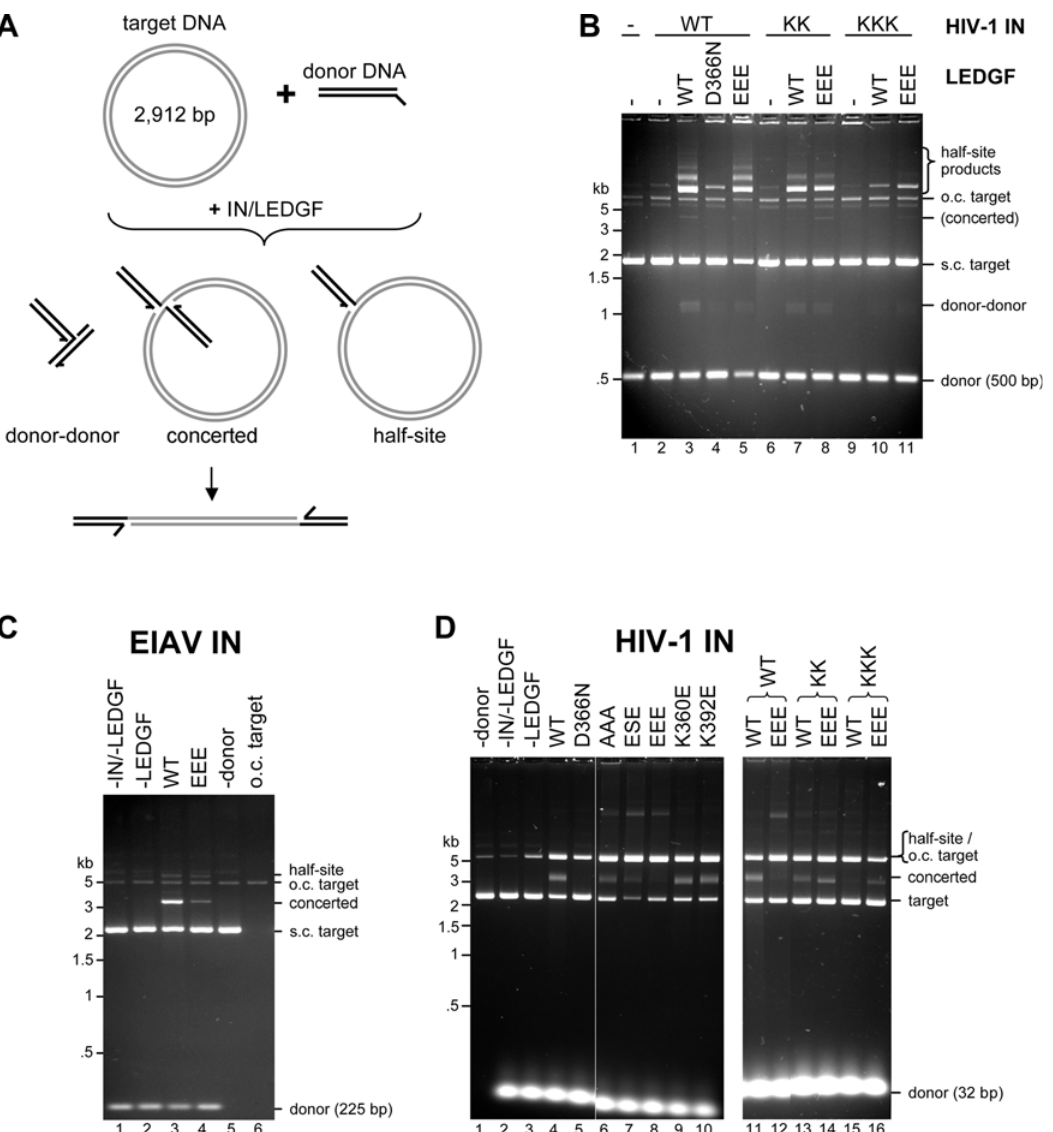
Figure 4. Effects of Mutations within the NTD–IBD Interface on LEDGF–Dependent Strand Transfer Activities of Lentiviral INs. (A) Schematic of the reactions mediated by IN in the presence of circular DNA target: concerted integration results in a linear product while half-site reactions produce branched molecules (circular half-site and donor-donor). (B) HIV-1 IN activity under established conditions that favor half-site integration [22]. WT, KK, or KKK HIV-1 IN was incubated with 10 nM 500-bp donor DNA and supercoiled target DNA in the absence (lane 2) or presence (lanes 3–11) of WT, D366N, or EEE LEDGF. The products separated in an agarose gel were detected with ethidium bromide. Lane 1 contained a mock sample, with both IN and LEDGF omitted. (C) EIAV IN reactions. EIAV IN was incubated with 10 nM 225-bp donor DNA and supercoiled target DNA in the absence (lane 2) or presence (lanes 3 and 4) of WT or EEE LEDGF, as indicated. Lane 1 contained a mock sample without IN and LEDGF; lane 5 contained IN and WT LEDGF without donor DNA; lane 6 contained 10 ng of singly-nicked pGEM-9Zf(-) [22] as a migration standard for the open circular (o.c.) form of target DNA. (D) Enhanced concerted HIV-1 integration assay using an elevated input of donor DNA (for details, see Text S1 and Figure S4). WT, KK, or KKK HIV-1 IN was incubated with 0.5 m M pre-processed 32-bp donor and supercoiled target DNA in the presence of WT, D366N, AAA, ESE, EEE, K360E, or K392E LEDGF. Migration positions of various DNA species (size standards, supercoiled [s.c.] and o.c. target, donor, and reaction products) are